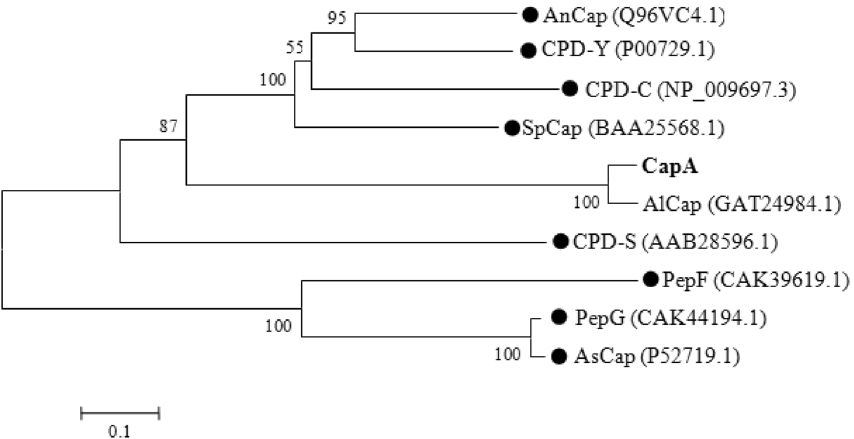
Figure 2. Phylogenetic tree describing the genetic distances among various serine carboxypeptidases from different microorganisms. The serine carboxypeptidase in this research is shown in bold. The length of the line segment is the distance calculated by MEGA 5.0. The number on the branch node represents the bootstrap percentage. Values less than 50% are not shown. The black dots indicate that the carboxypeptidase has been reported in the literature. The entry number of the enzyme protein in GenBank is indicated in brackets. AnCap 24 is from A. nidulans , CPD-Y 25 and CPD-C 26 is from S. cerevisiae , SpCap 27 is from S. pombe , AlCap is from A. luchuensis . CPD-S 28 is derived from P. janthinellum , PepF and PepG 15 from A. niger , and AsCap 29 from A. saitoi .